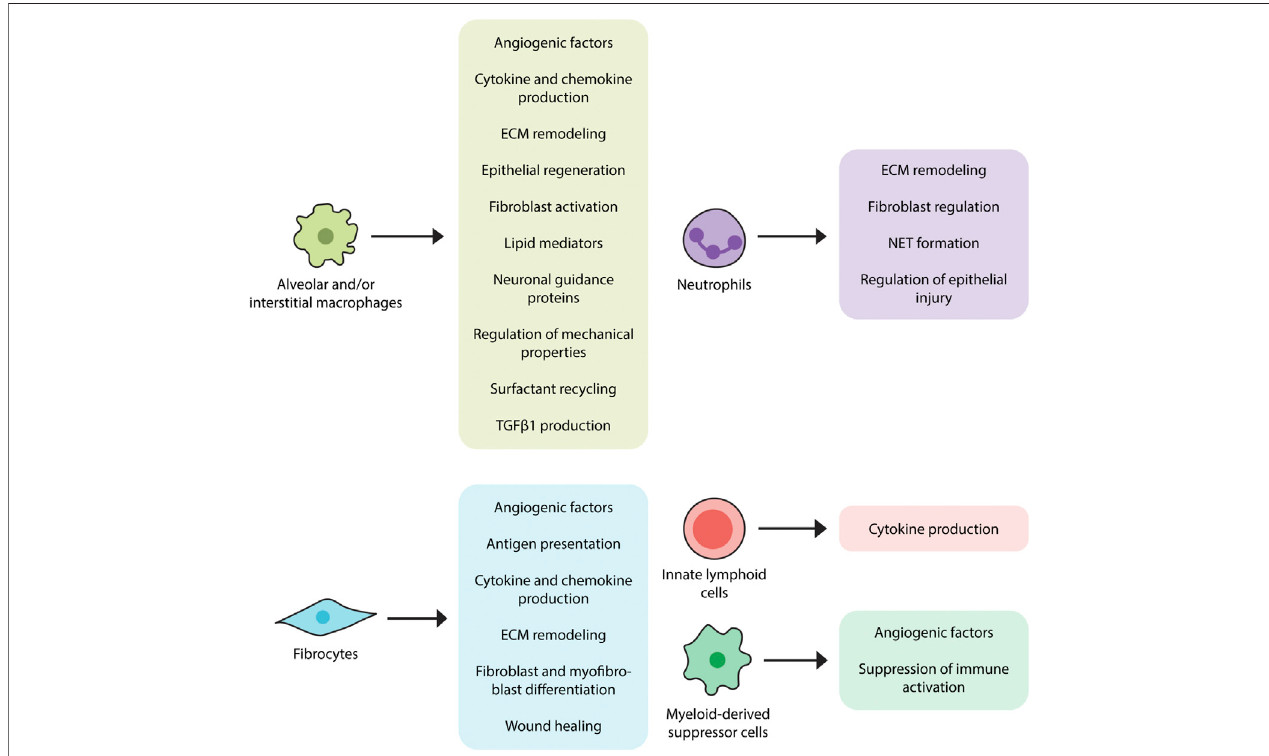
FIGURE 2 | Proposed contributions of innate immunity in pulmonary fi brosis. Innate immune cell populations, ranging from macrophages to innate lymphoid cells, have displayed fi bromodulatory properties in response to stimuli such as pathogen-associated molecular patterns (PAMPs) and danger-associated molecular patterns (DAMPs).AlveolarandinterstitialmacrophagesproduceTGF β 1,angiogenicfactors,variouscytokinesandchemokines,lipidmediators,andneuronalguidanceproteins, induce ECM remodeling, and regulate surfactant recycling and mechanical properties ofthe lung. Neutrophils also participate in the regulation of ECMremodeling, aswellastheformationofextracellularneutrophiltraps, whichmayhavepro- fi broticeffects.Fibrocytes,inaccordancewiththeirmultilineagefeatures,exhibitavarietyof fi brosis-promoting functions, including antigen presentation, cytokine and chemokine production, differentiation into fi broblasts and myo fi broblasts, and wound contraction. Myeloid-derived suppressor cells (MDSCs) function to dampen immune responses and are also involved in vascular remodeling while innate lymphoid cells (ILCs) have been shown to produce pro- fi brotic